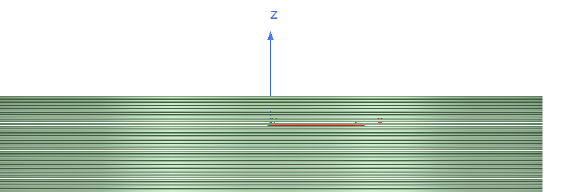
Figure 8. Front view of the model with 3.6 mm spacing between the first 5 cakes. Table 9. Changes in circuit parameters.